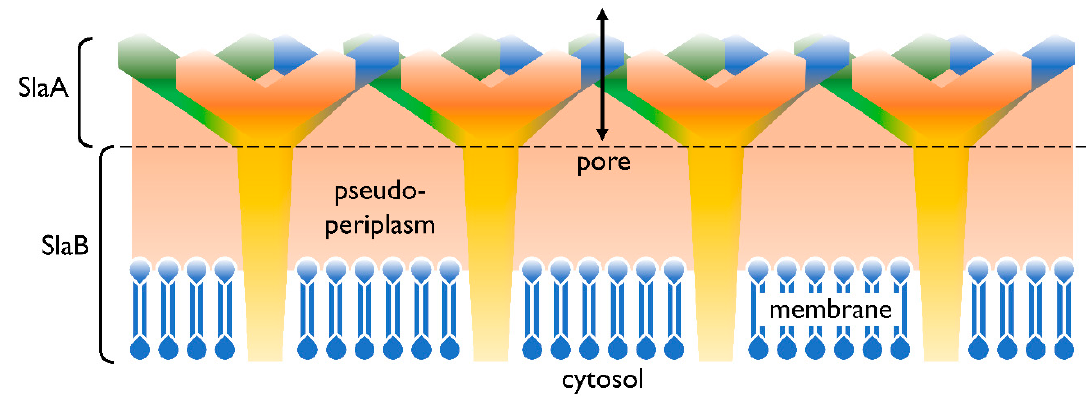
Figure 1. Cell envelope profile of Sulfolobus spp. The semi-permeable surface (S-)layer is comprised of the proteins SlaA (sheath) and SlaB (shaft). Both SlaA and SlaB are protein trimers and the contact area of these trimers is indicated with a dashed line. The salmon colored area represents the pseudoperiplasmic space. In Sulfolobus spp., the membrane is predominantly comprised of membrane spanning tetraether lipids [25,31].